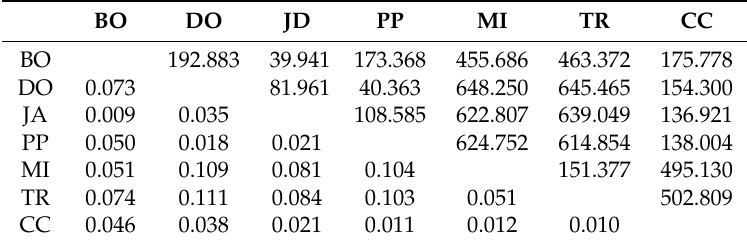
Table 3. Pairwise estimation of genetic differentiation among Campomanesia adamantium populations in the lower triangle and geographic distance (km) in the upper